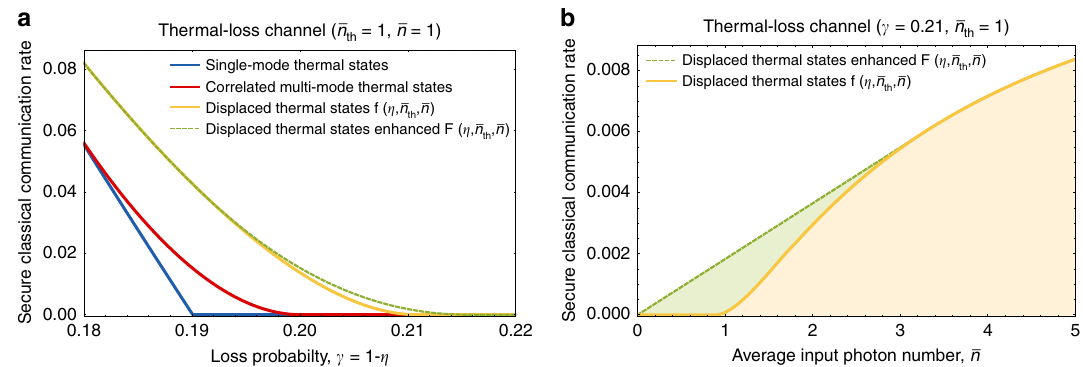
with th (cid:2) ; (cid:2) n Þ ; see also Eq. (24)) obtained by using the displaced thermal state in Eq. (22). The dashed th ; (cid:2) n Þ ; see also Eq. (25)) obtained by using the classical-quantum state we constructed in Eq. (39). th with η = 0.79 (or γ = 0.21) and (cid:2) n 1 as a function of the maximum allowed th (cid:2) th ¼ ; (cid:2) n Þ ) and the dashed green line represents our bound ( F ð η ; (cid:2) n ; (cid:2) n Þ ). th th ; (cid:2) n Þg properly contains the th